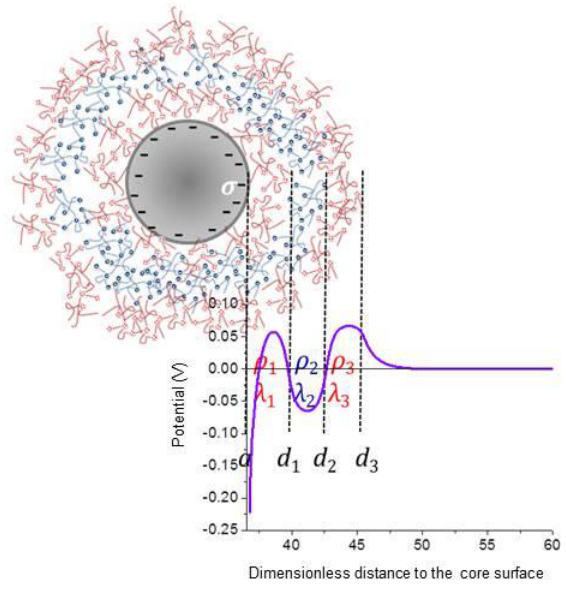
Figure 5. Electric potential vs. distance to the core surface for a triple polyelectrolyte layer. Calculations assuming that the core is a sphere 1000 nm in diameter and − 10 µ C/cm 2 surface charge, coated by successive layers of PDADMAC (40 nm 7 × 10 5 C/m 3 ), PSS (40 nm − 7 × 10 5 C/m 3 ), and PDADMAC (40 nm 7 × 10 5 C/m 3 ).